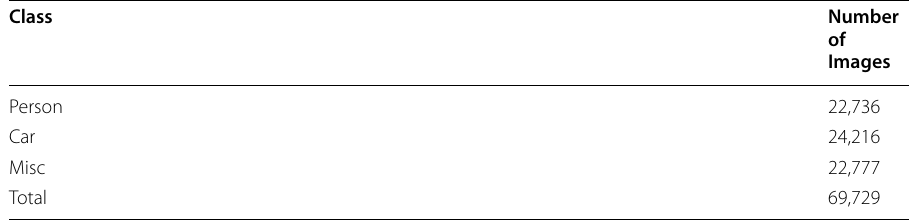
Table 2 Number of images of each class in the training set of the ResNet18 classifier